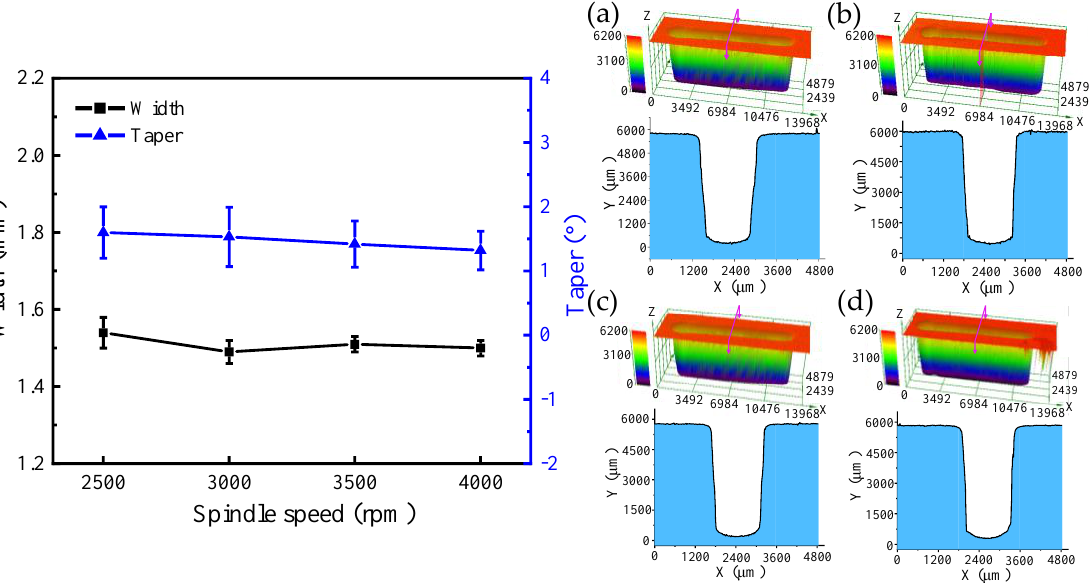
Figure 13. The dimension and 3D profile of DNGs milled with different spindle speeds: ( a ) spindle speed = 2500 rpm; ( b ) spindle speed = 3000 rpm; ( c ) spindle speed = 3500 rpm; and ( d ) spindle speed = 4000 rpm.